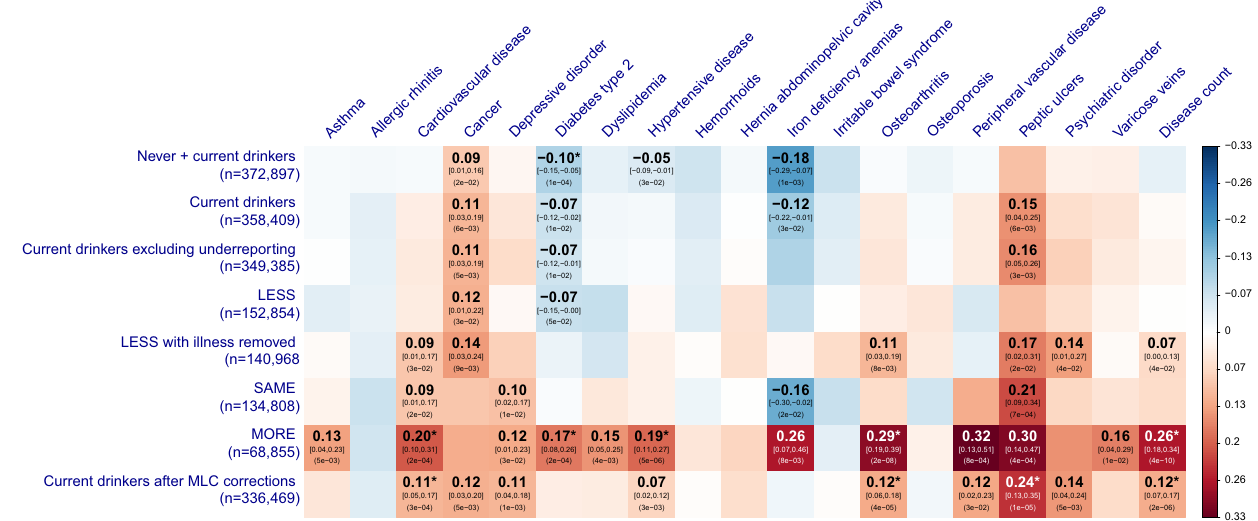
Fig. 2 Estimates of genetic correlation between AC and common diseases in the UKB. The rows denote 8 GWAS summary data sets for AC with the sample size labelled in the bracket. The columns are 18 common diseases and disease count. The nominal signi fi cant effects ( P < 0 : 05) are labelled with ^ r g [95% con fi dence interval] ( P -value), and the signi fi cant effects after multiple testing correction ( P < 0 : 05 = 152) are labelled with an additional asterisk. The colour of the block represents the size each genetic correlation estimate. The P -value shown in the block is the original P -value for ^ r g (two-sided χ 2 test). “ Current drinkers excluding underreporting ” represents current drinkers excluding 9,064 individuals who likely underreported their AC levels. LESS, SAME, and MORE represent current drinkers whose AC levels were reduced, maintained the same, and increased, respectively, compared to 10 years ago. “ LESS with illness removed ” represents the LESS group excluding the participants who reduced their AC intake level due to illness or doctor ’ s advice.